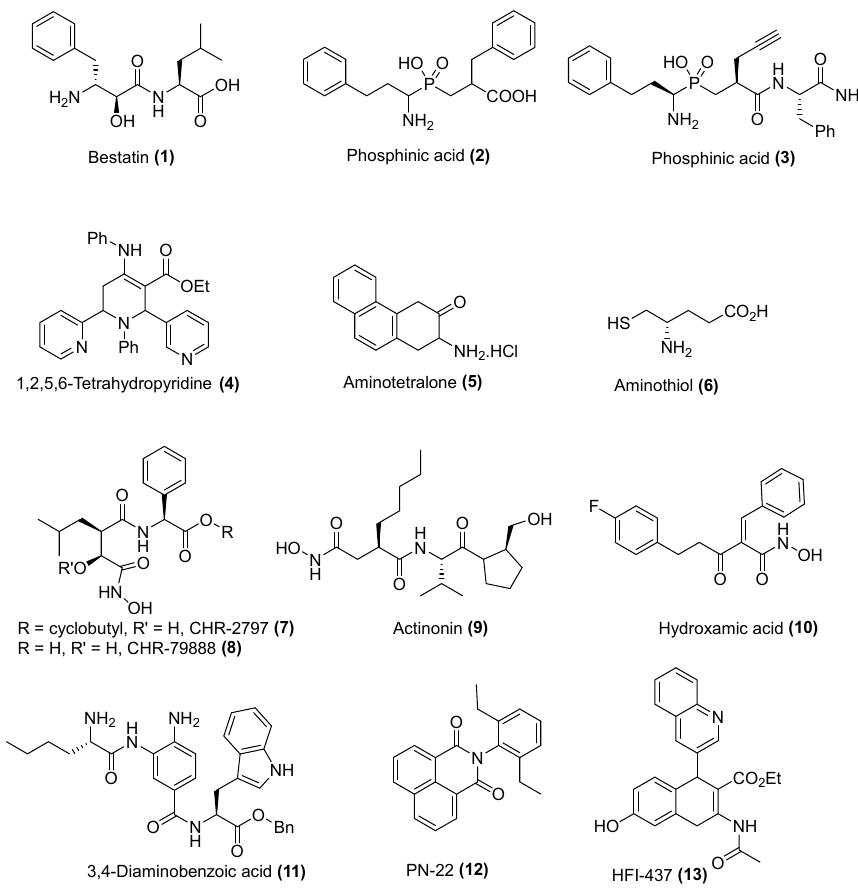
Figure 1. Representative inhibitors of M1 aminopeptidases (non-exhaustive list) For more detailed structures see references [11,28–31].